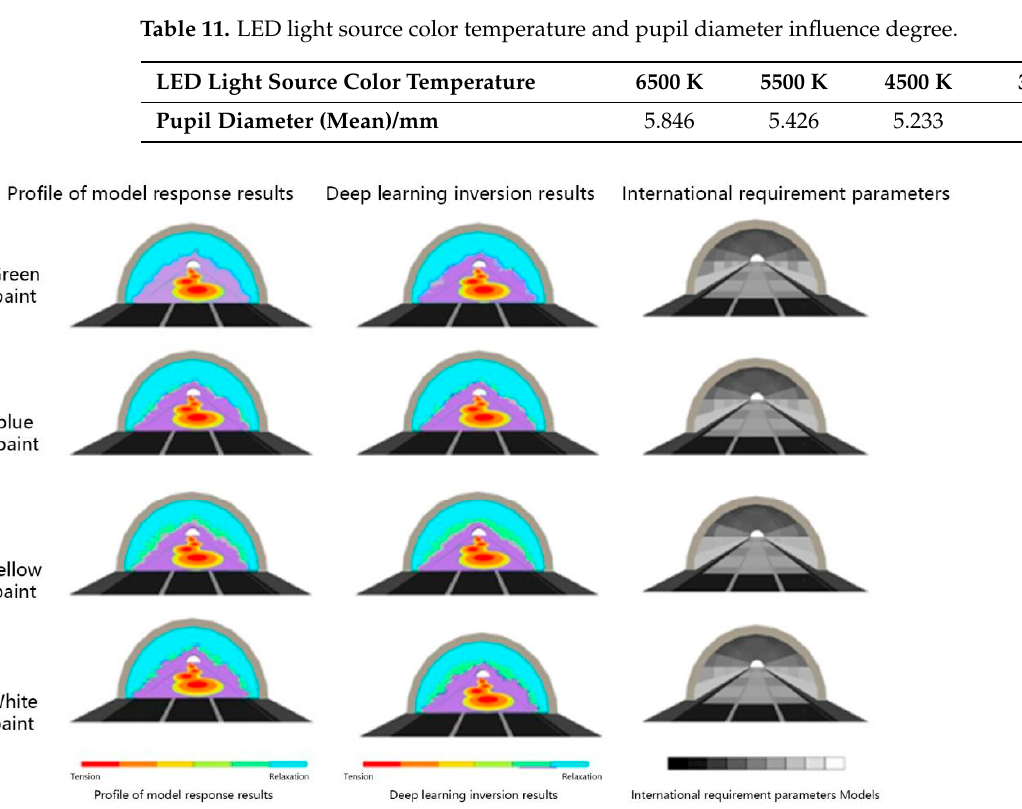
Figure 8. Sidewall reflective paint color sensitivity